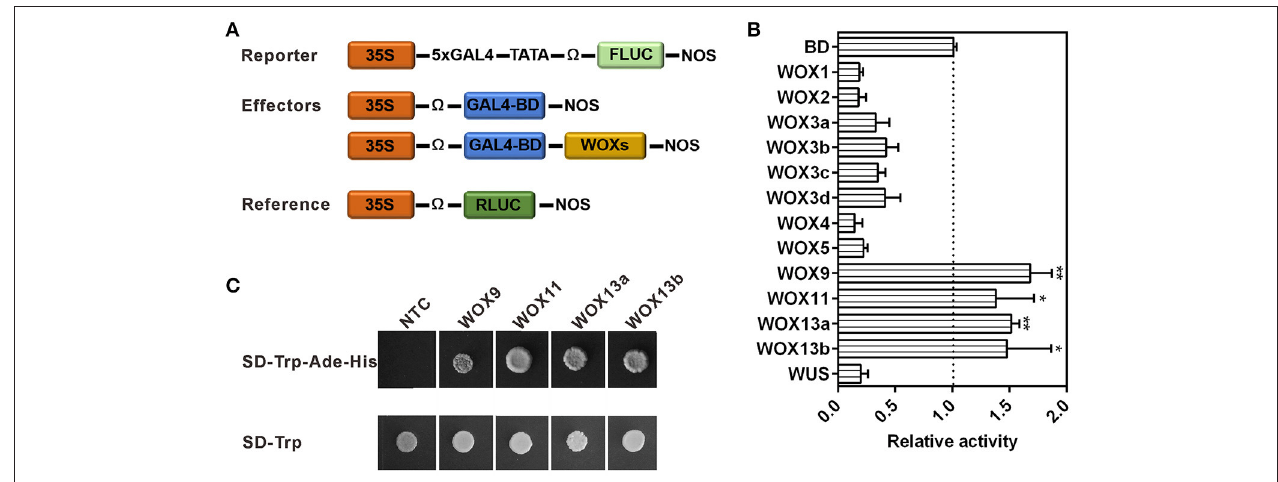
FIGURE 7 | The repressive or activation activities of WOXs in tobacco. (A) Reporter, effector, and reference constructs used in transient expression analysis. (B) Relative luciferase activities of each effector compared with GAL4-DB control. Error bars indicate standard error from four independent experiments. * and ** indicate statistical difference compared to the control ( t -test, p < 0.05, or p < 0.01, respectively). (C) The transcriptional activation activities of WOXs in